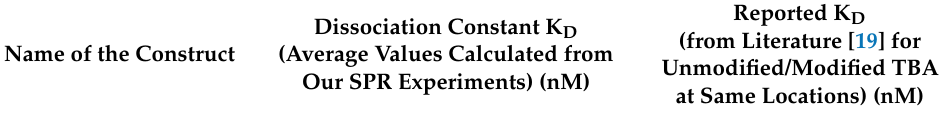
Table 1. Dissociation constant values (K D ) for the different